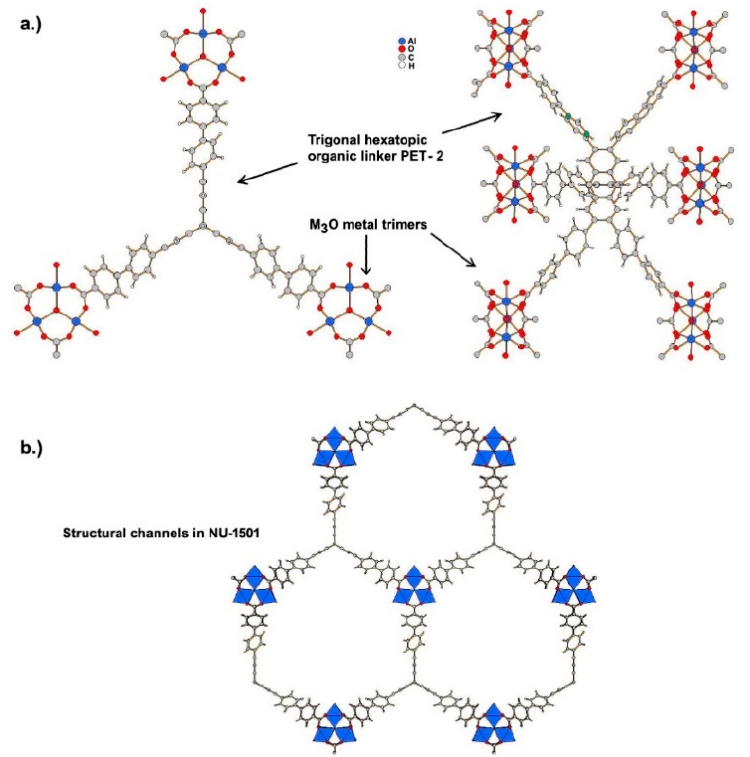
Figure 6. ( a ) Coordination of peripherally extended triptycene (H 6 PET-2) to metal cations forming M 3 O metal trimers. ( b ) Structural channels in NU-1501 viewed along c axis. M 3 O metal trimers. ( b ) Structural channels in NU-1501 viewed along c